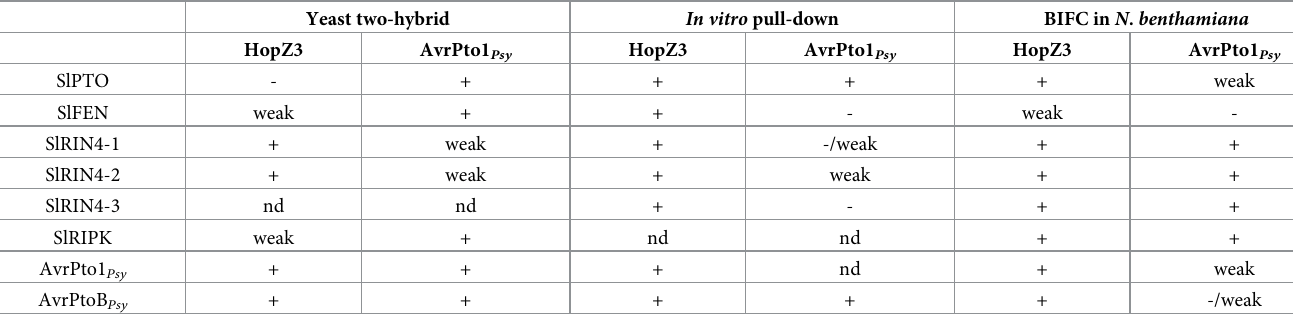
Table 1. HopZ3 interacts with members of a tomato immune